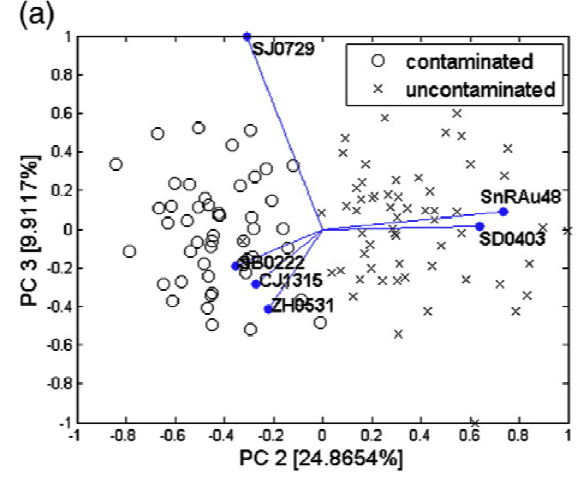
Figure 10. Biplots showing the capability of EN EOS835 in discriminating uncontaminated and ACB contaminated samples of soft drinks (( a ) peach-based; ( b ) pear-based and ( c ) apple based). Reprinted from [45] with permission of Elsevier Food